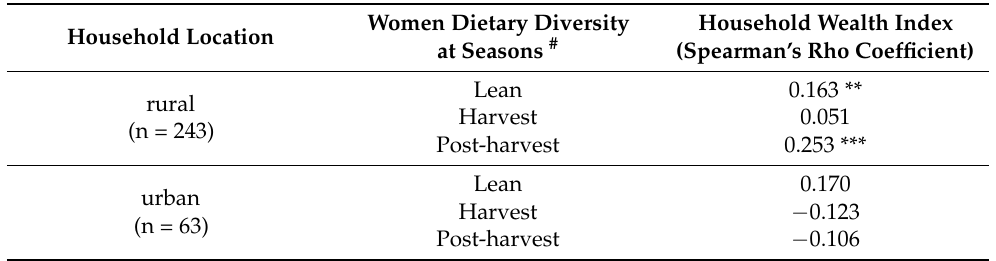
Table 3. Spearman correlations between women’s dietary diversity and household wealth index across agricultural